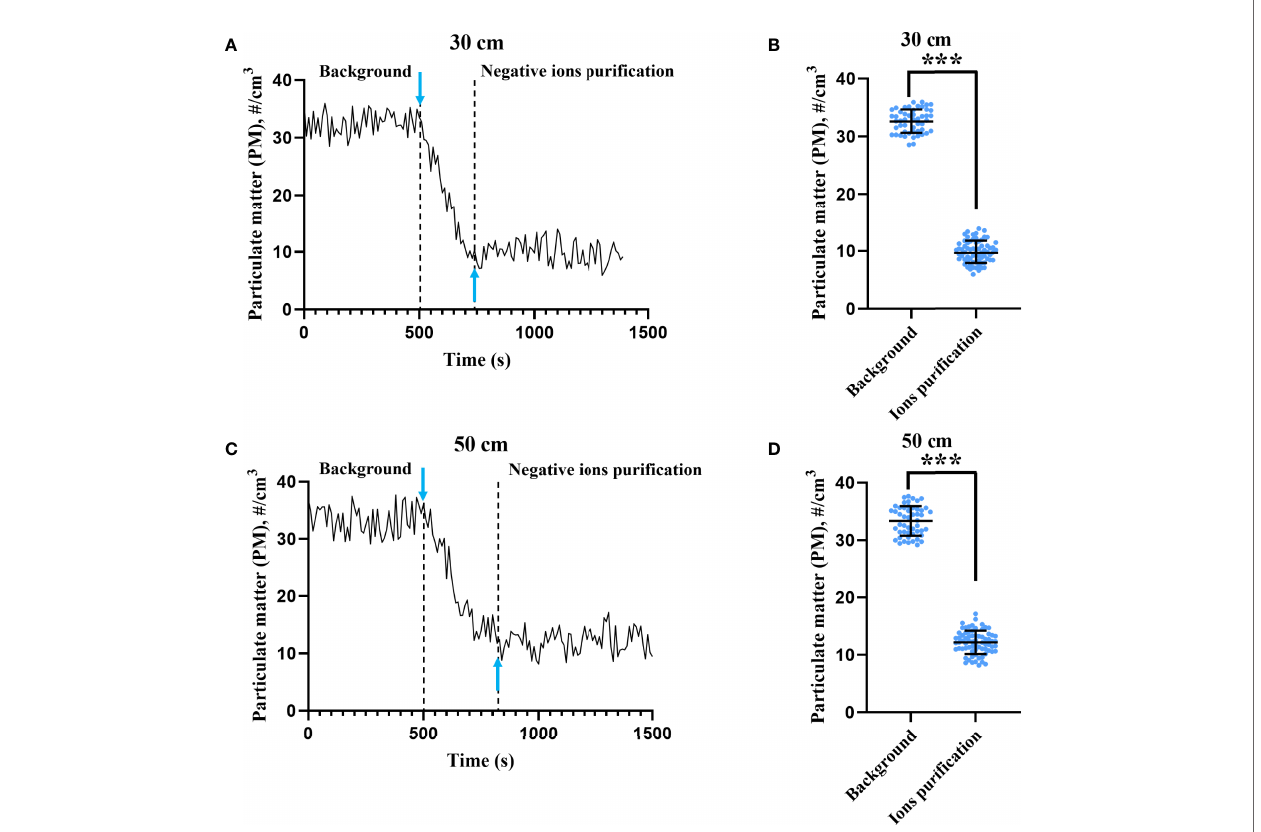
FIGURE 1 | Particulate matter puri fi cation effect by negative ions. The concentrations of particulate matter (PM) were monitored by two laser particle counters placed 30 (A) and 50 cm (C) above the ionizer. Downward arrow means that the ionizer was switched on at that moment. Upward arrow indicates the moment when the concentration of PM fi rst dropped to the mean value after negative ion puri fi cation. The PM concentrations before and after negative ion puri fi cation at 30 (B) and 50 cm (D) height were also compared. The bar means: Mean ± SD. *** means P value <0.001.